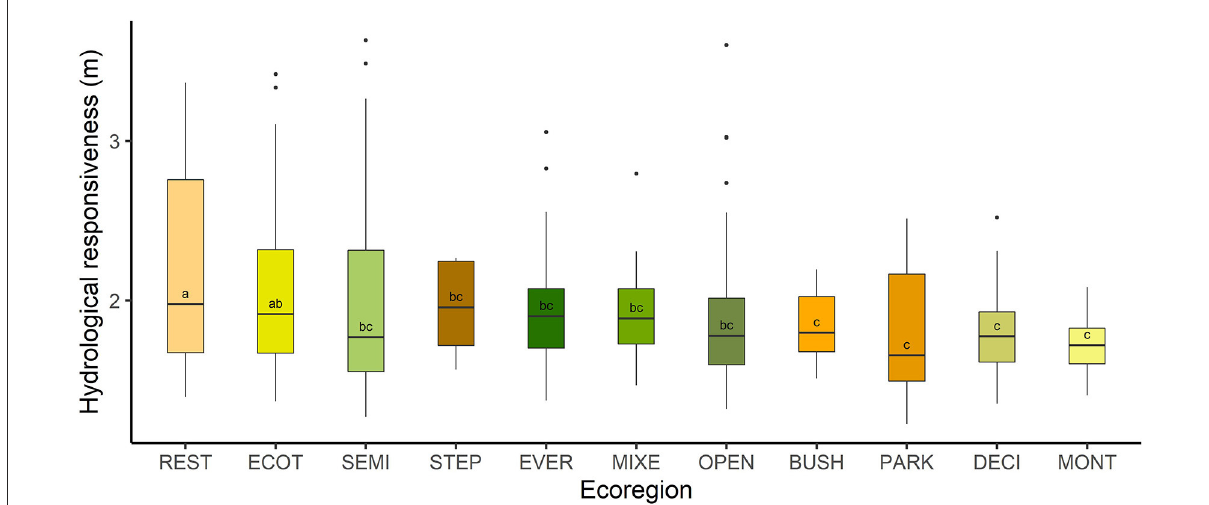
FIGURE2 Hydrological responsiveness (m) of the Atlantic Forest ecoregions, Brazil. REST, Arboreal restinga and mangrove; BUSH, Bushy grassland; DECI, Deciduous broadleaved forest; ECOT, Ecotone; EVER, Evergreen broadleaved forest; MIXE, Mixed needle-broadleaved forest; MONT, Montane and upper montane forest; OPEN, Open ombrophilous forest; PARK, Parkland savanna; SEMI, Semideciduous broadleaved forest; STEP, Steppe savanna. Treatments labeled with different letters indicate a significant difference between the means ( p < 0.05, analysis of variance followed by multiple comparison test).